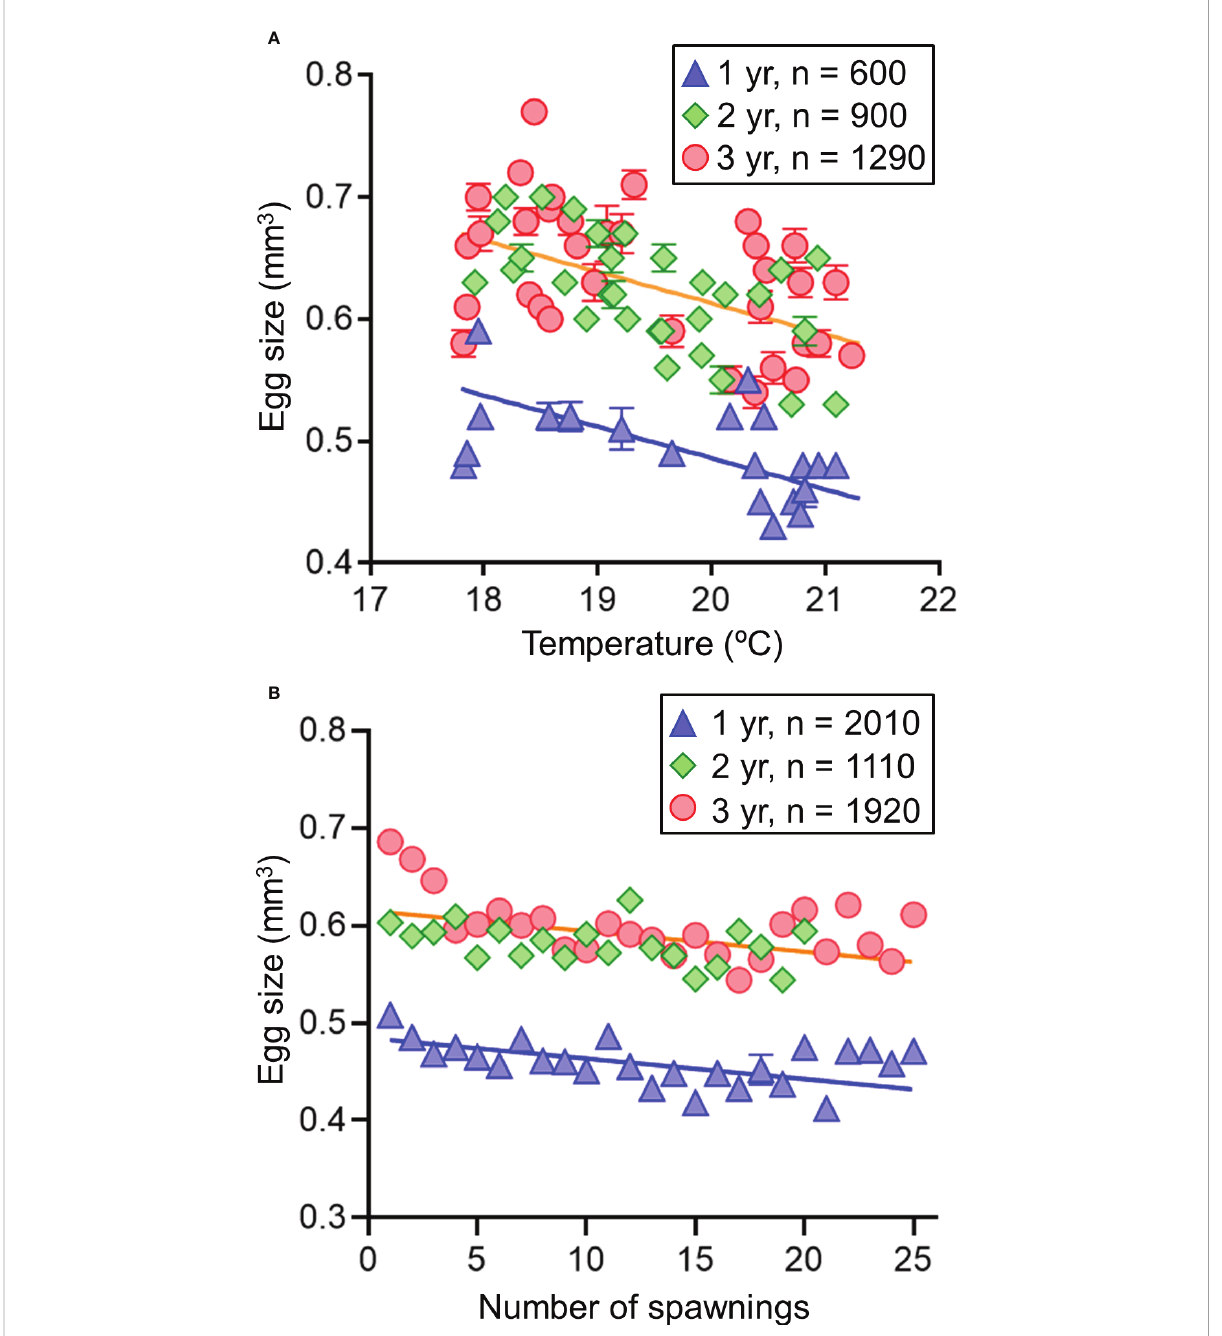
FIGURE 3 Relationships of egg volume (A) with ambient temperature (B) and the number of spawning events at constant temperature (19°C) of 1-, 2-, and 3-year-old chub mackerels. Predicted lines using the linear mixed effect models fi tted to observed data are shown (blue line: age 1 year; orange line: age 2 and 3 years). Data are shown as mean ±